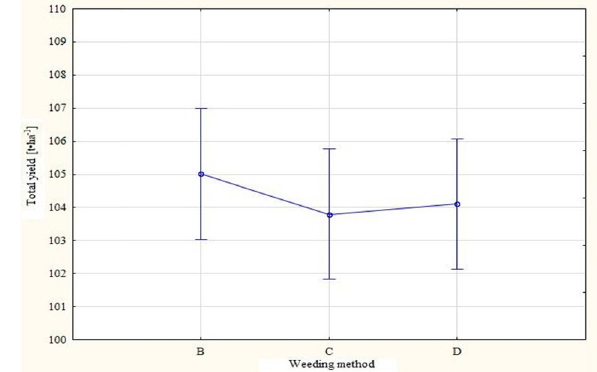
Figure 6: The expected marginal averages for 0.95 con fi dence intervals for total yield according to the various methods of weeding carrots in 2016 ( source: own work ) .